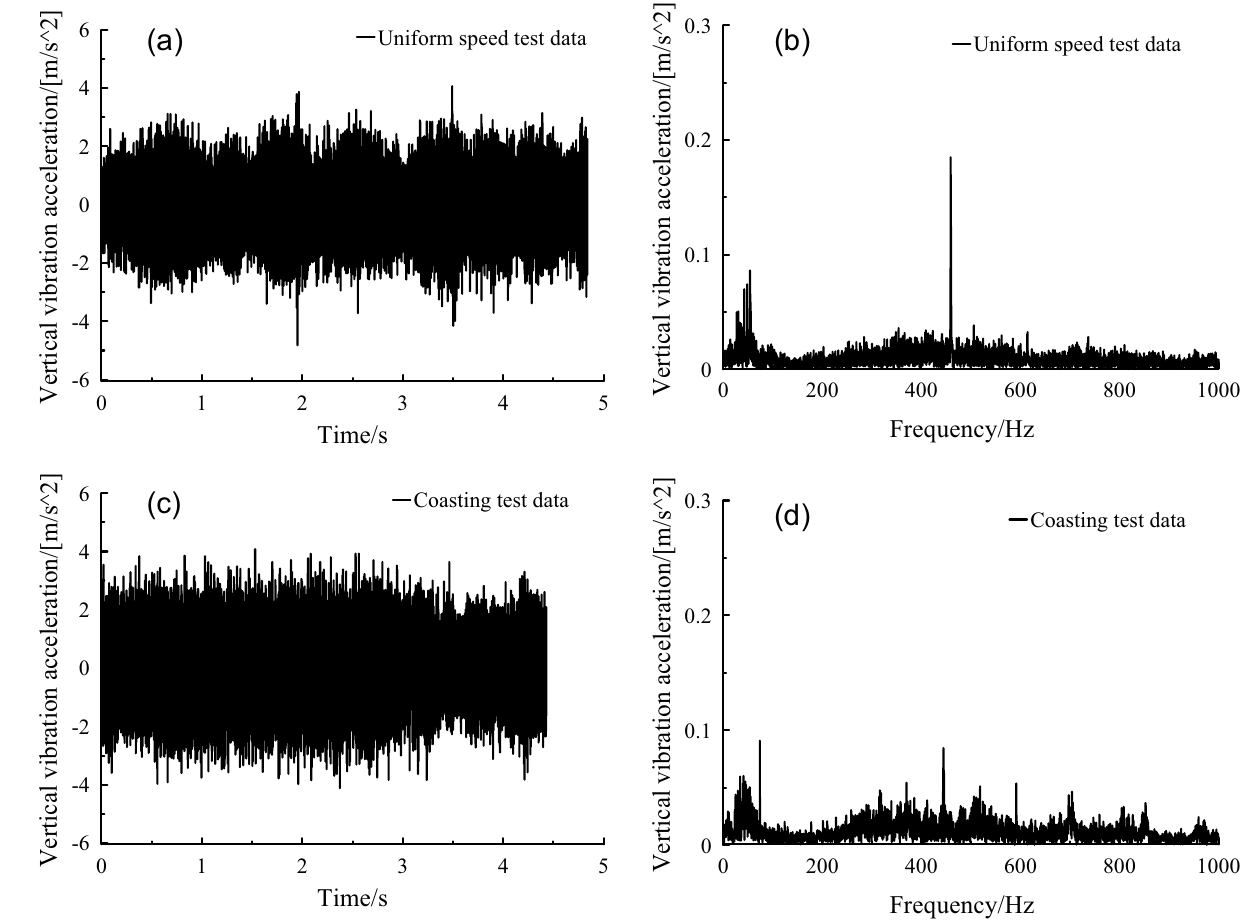
Figure 10. Frame vertical vibration acceleration, at (a-b) uniform speed, (c-d) coasting